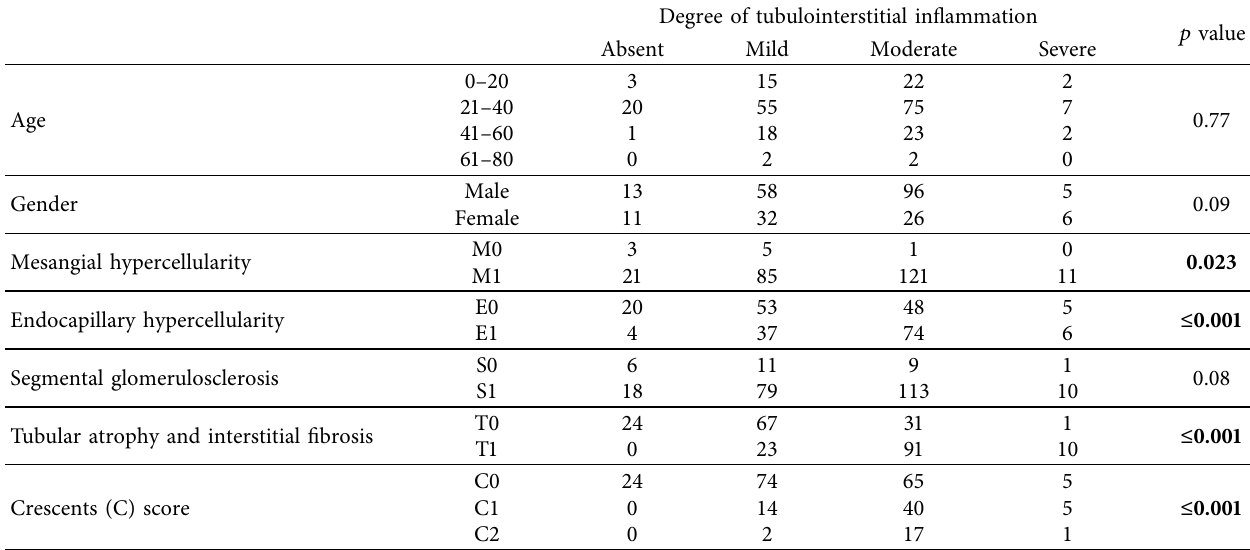
Table 5: Relationship between MEST-C score and the degree of tubulointerstitial